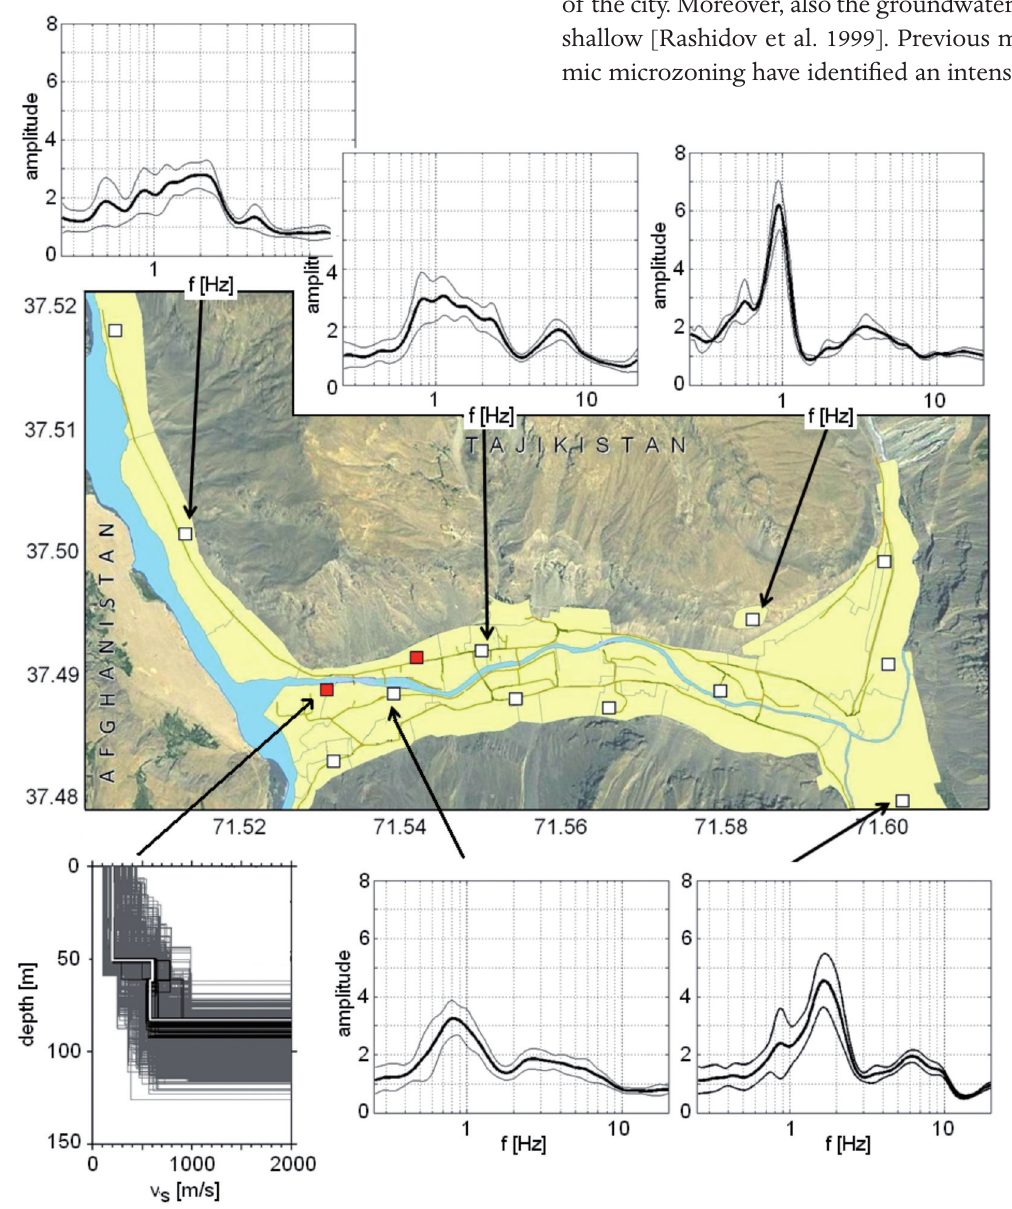
Figure 7. Network layout (white dots) and array measurement sites (red dots) in the city of Khorog. Horizontal-to-vertical spectral ratios for earthquakes plus/minus one standard deviation are shown for representative stations. For the western array measurement site the shear- wave velocity profile is shown. Thin gray lines show all tested models. The white line represents the minimum cost model and the black lines indicate all models lying inside the minimum cost +10%